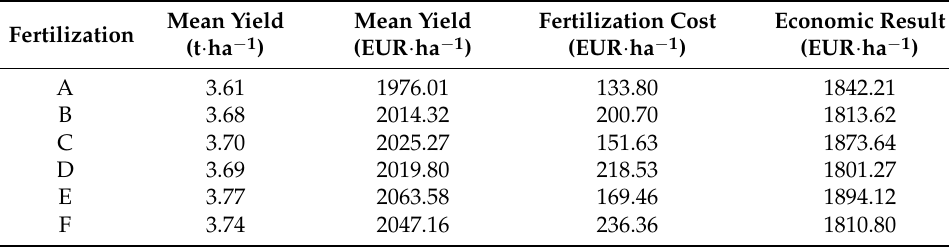
Table 6. Economic result of the applied fertilization per 1 ha.